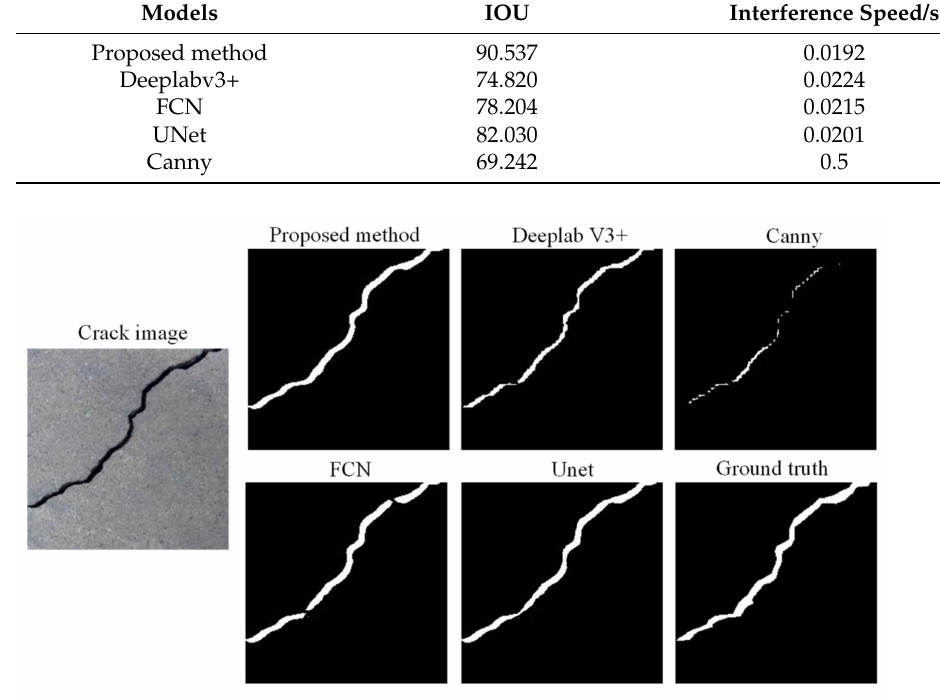
Figure 10. Comparison of calculation effects of different crack detection